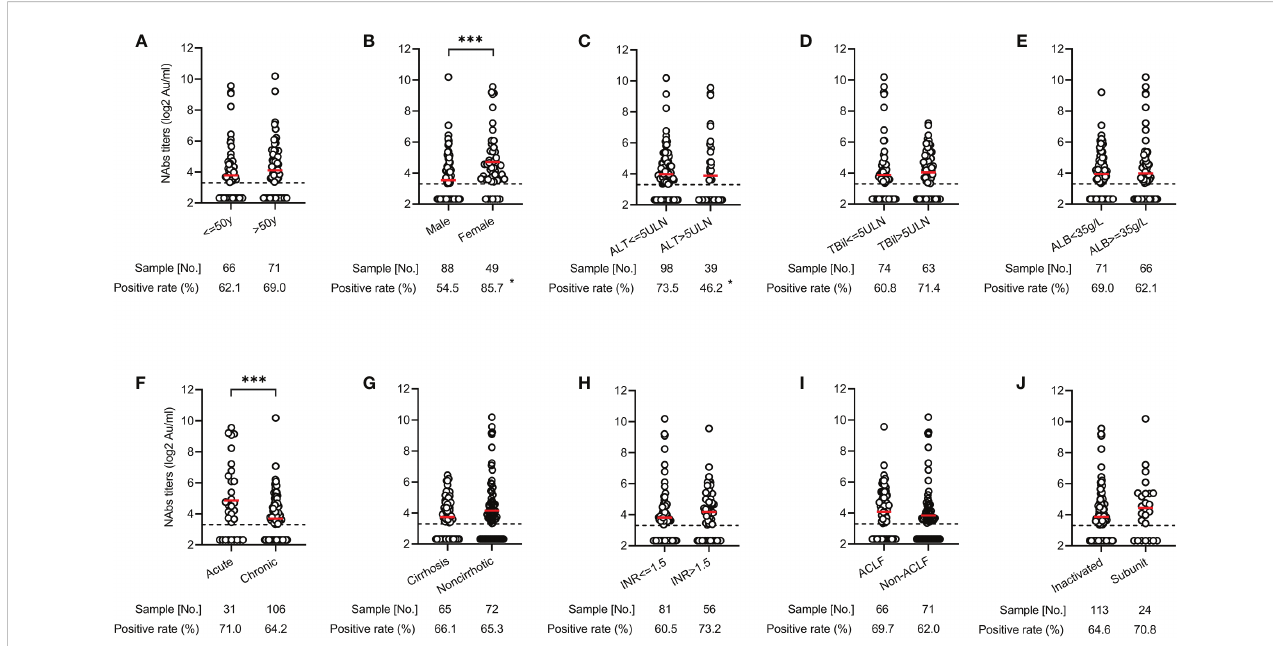
FIGURE 2 Distribution of antibody responses after COVID-19 vaccination across various clinical parameters in patients with liver dysfunction. Comparison of NAbs seropositivity and titers in the different age ( ≤ 50 vs >50 years) (A) , gender (male vs female) (B) , ALT level ( ≤ 5×ULN vs >5×ULN) (C) , total bilirubin level ( ≤ 5×ULN vs >5×ULN) (D) , albumin level (<35 vs ≥ 35 g/L) (E) , liver disease status (acute vs chronic) (F) , cirrhosis (yes vs no) (G) , INR value ( ≤ 1.5 vs >1.5) (H) , ACLF (yes vs no) (I) , and vaccine types (inactivated vs subunit recombinant) (J) . *<0.05; ***<0.001. ACLF, acute on chronic liver failure; ALT, alanine aminotransferase;